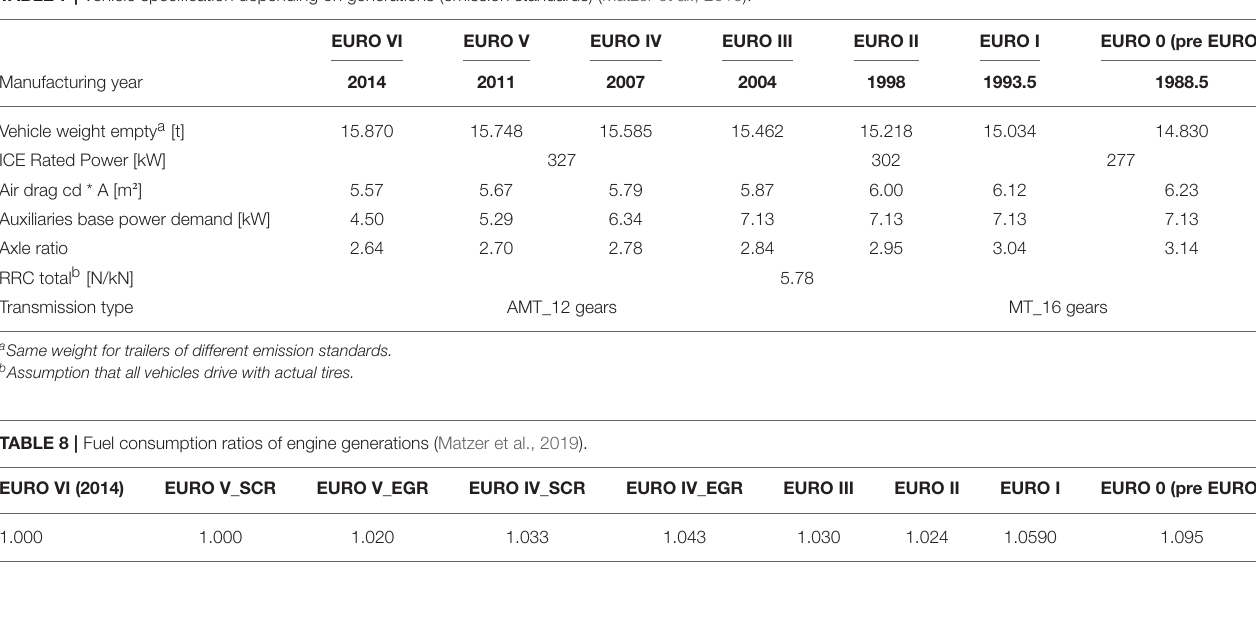
TABLE 7 | Vehicle specification depending on generations (emission standards) (Matzer et al., 2019).